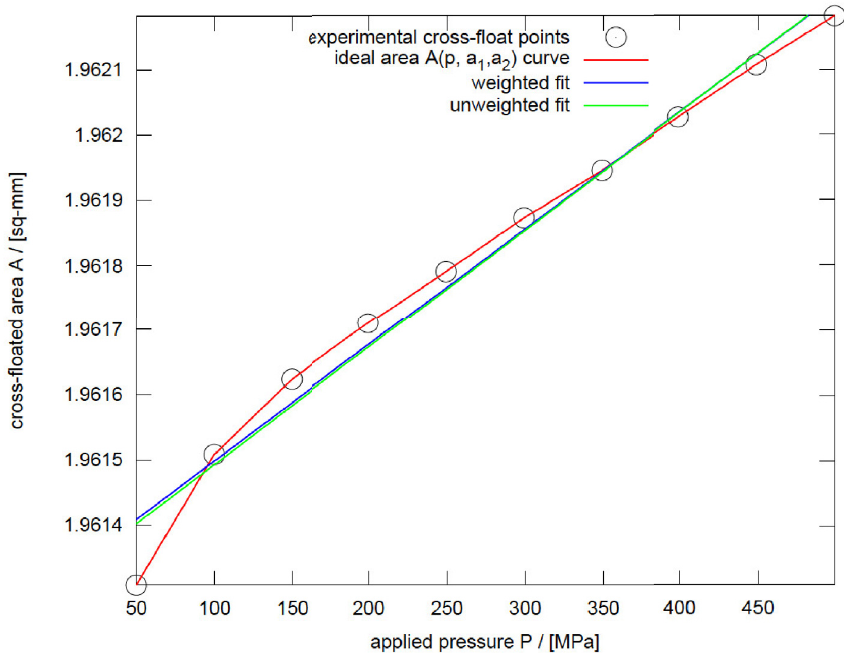
Fig. 1. (Color online) Results of direct pressure/area method calculations for a transfer standard pressure balance cali- brated by cross-float to a laboratory standard. The transfer standard pressure balance model parameter is evaluated as a = { A 0 , λ } = { 1 . 9613197257 mm 2 , 0 . 9116463858 ppm / MPa } with a corresponding standard uncertainty of u ( a ) = { 0 . 0000738752 mm 2 , 0 . 1223666979 ppm / MPa } i.e. u ( A 0 ) = ± 37 . 666 ppm and u ( λ ) = ± 13 .